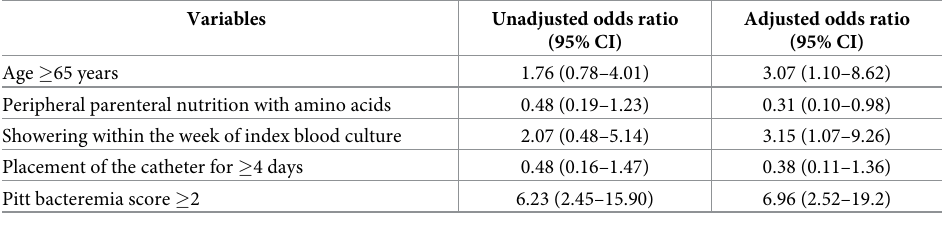
Table 3. Univariate and multivariate analysis of risk factors for peripheral intravenous catheter-associated gram- negative bloodstream infections. Variables